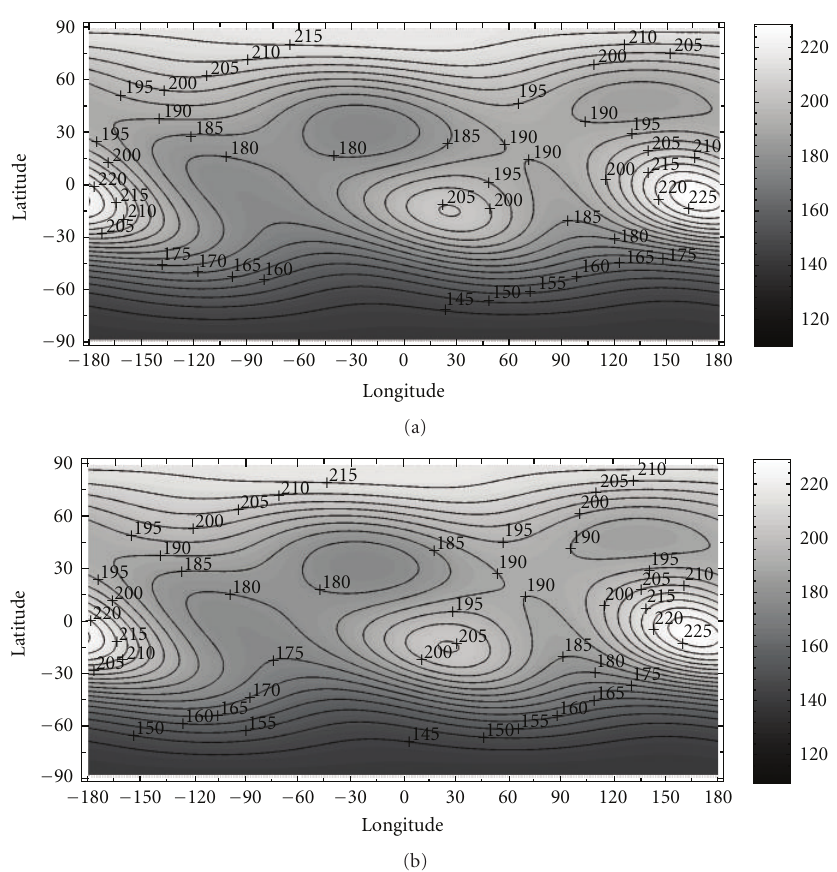
Figure 1: The global distributions of the atmospheric temperature (K) at 90 km altitude, obtained from the NRLMSISE-00 empirical model for 16 January, UT = 10 . 30 and calculated for two distinct values of solar activity: F 10 . 7 = 101 (a) and F 10 . 7 = 230